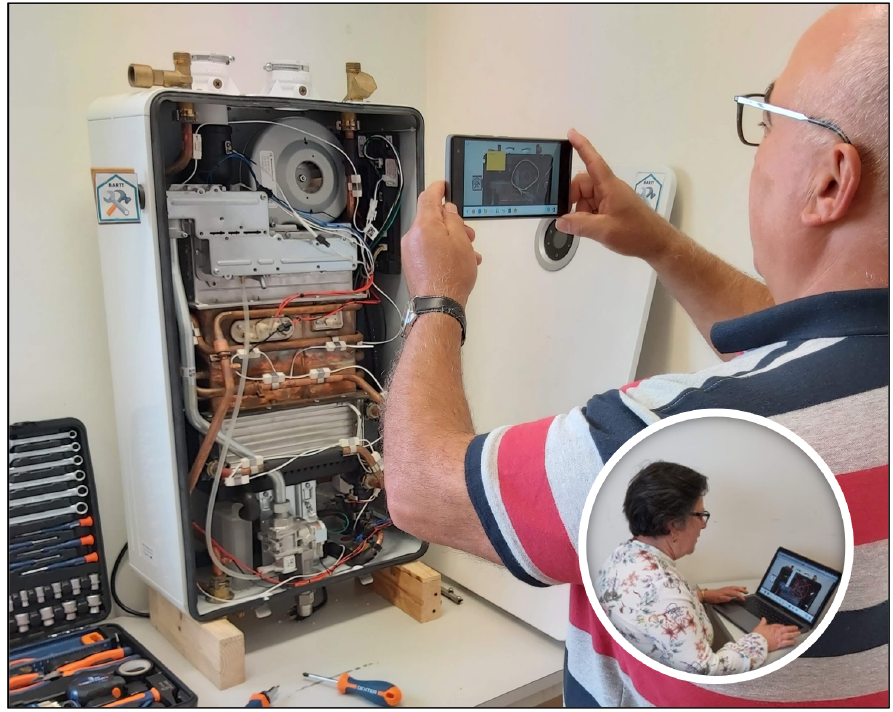
Figure 12. Remote team members collaborating through the AR-based tool: on-site participant being assisted by a remote